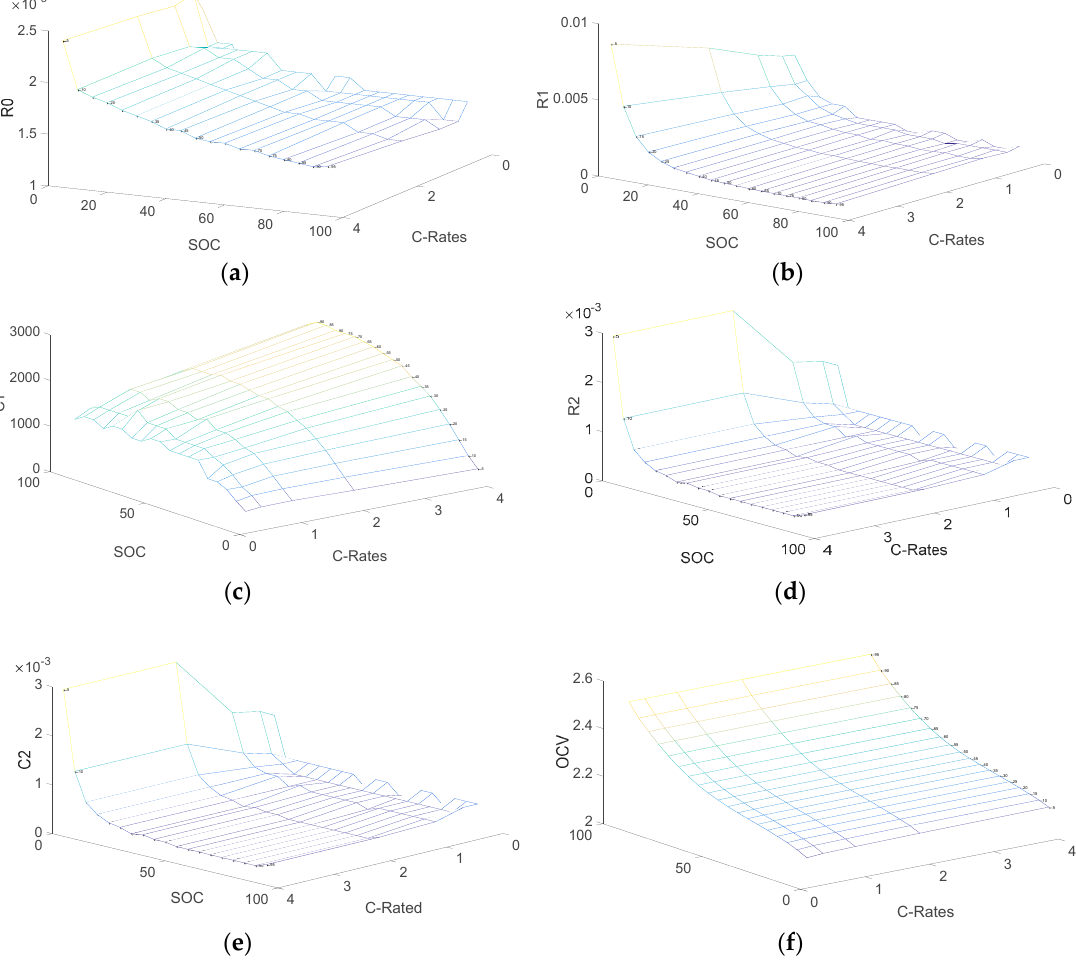
Figure 9. Amount of ( a ) R 1 , ( b ) R 2 , ( c ) C 1 , ( d ) C 2 , ( e ) V 0 and ( f ) OCV.